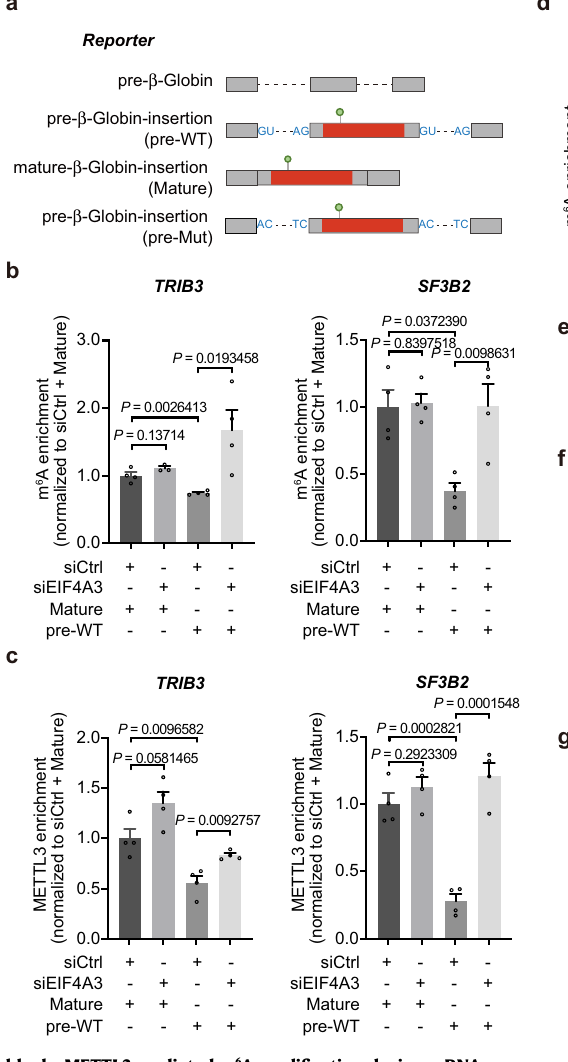
m 6 A modi fi cation might be related to nonsense-mediated decay (NMD) pathways.